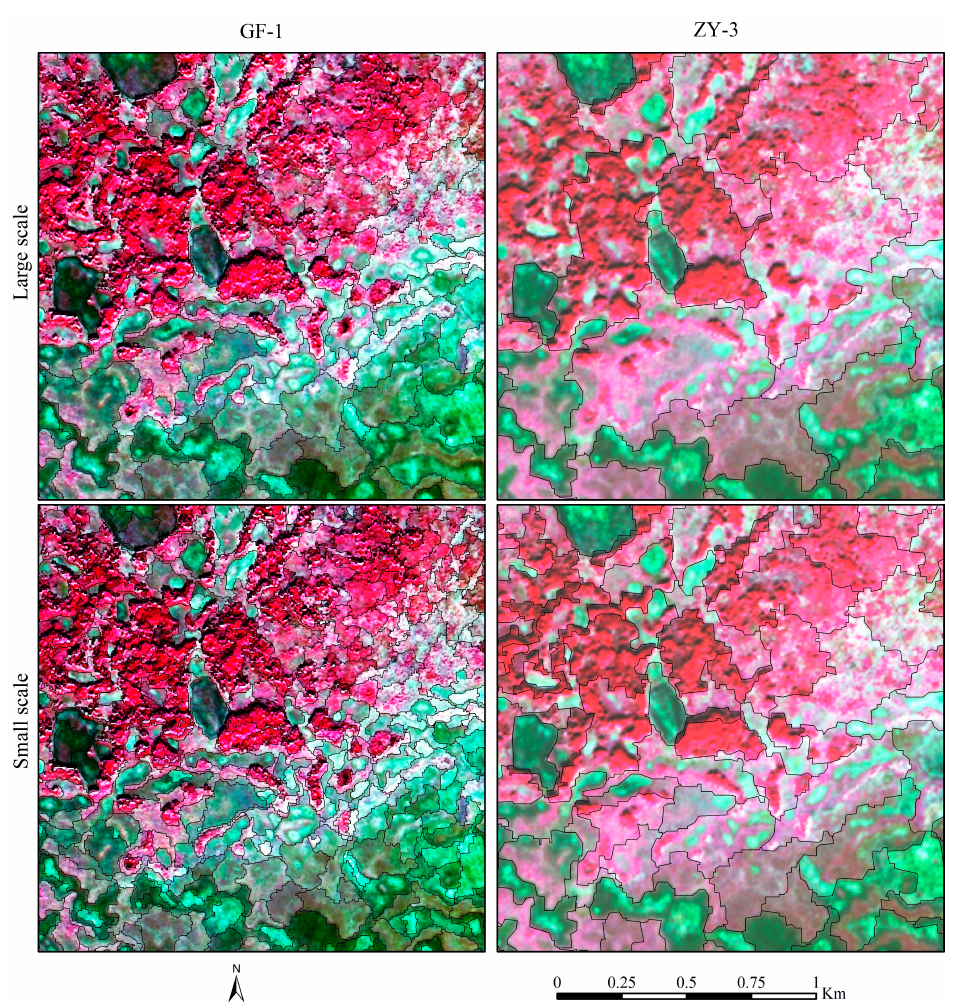
Figure 2. Segmentation base on GF-1 and ZY-3 false-color image display: bands 4, 3, 2 in red, green, blue (RGB) using different scale parameters with color/shape weighting (0.7/0.3) and